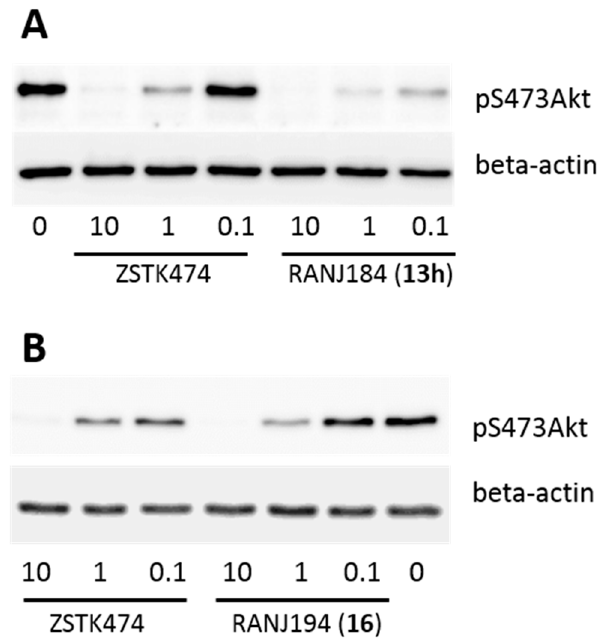
Figure 1. Representative western blots of S473 protein kinase B (Akt) phosphorylation in C4-2 prostate cancer cells. ( A ) C4-2 cells were treated with ZSTK474 or compound 13h (Scheme 4; 10, 1, or 0.1 µM each). ( B ) C4-2 cells were treated with ZSTK474 or compound 16 (Scheme 4; 10, 1, or 0.1 µM each). Equal loading was controlled by probing western blot for beta-actin.